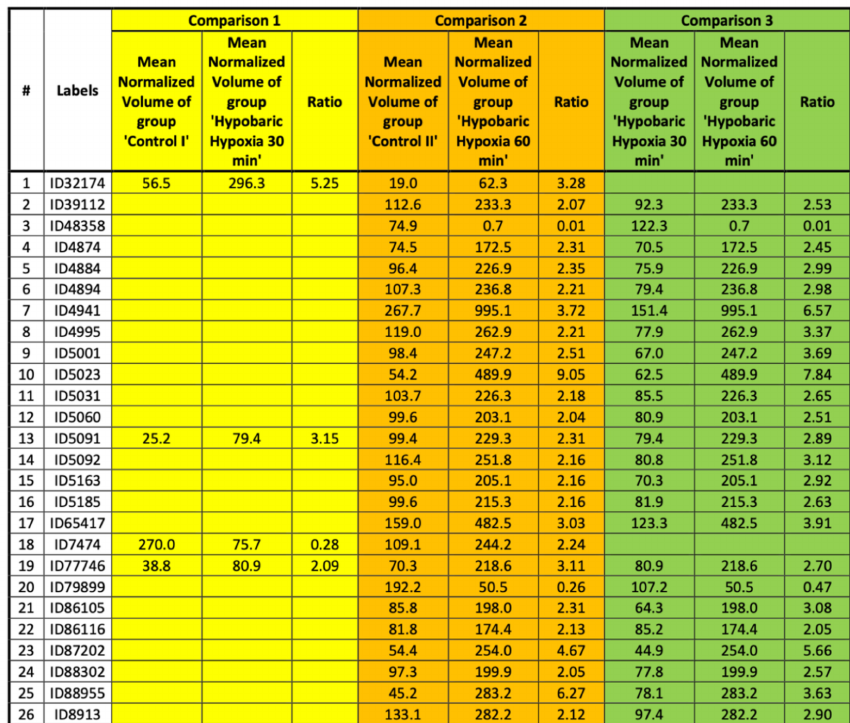
Figure 14. Spots found changed in more than one